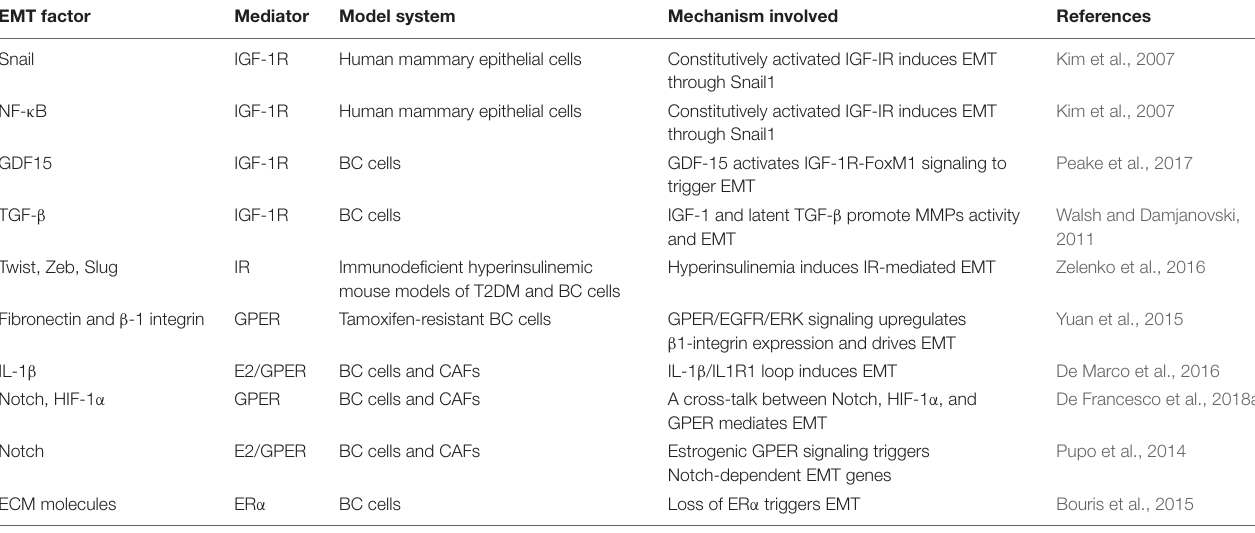
TABLE 1 | Schematic representation of the EMT factors modulated by estrogen and IIGF signaling in BC.